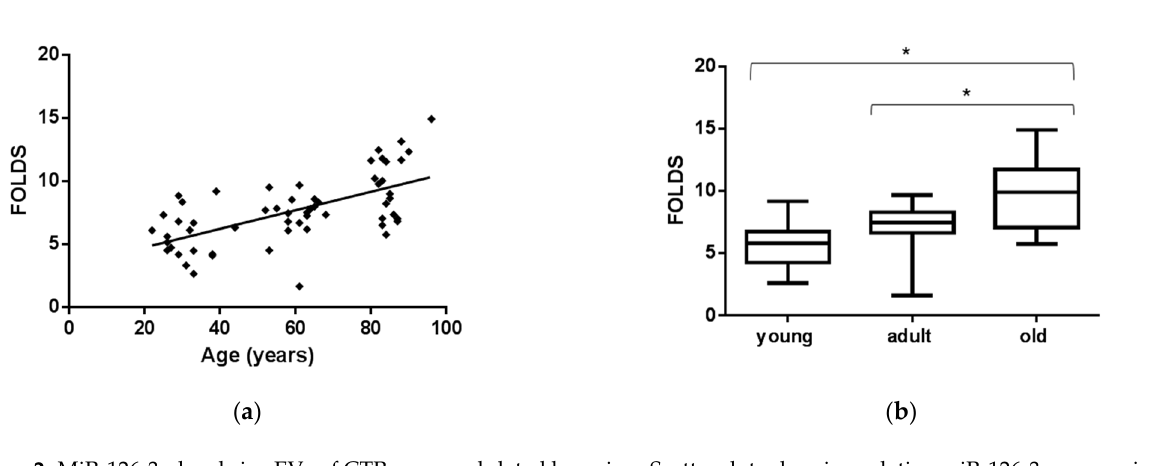
Figure 1. Representative Nanoparticle Tracking Analysis (NTA) analysis of small extracellular vesicles (sEVs) collected by ultracentrifugation method; sEVs isolated from plasma of different age classes of CTRs and FD EVs had a mean diameter of 138.9 +/ − 1.9 nm and mode of 111.8 +/ − 4.5 nm, here called small extracellular vesicles (sEVs).